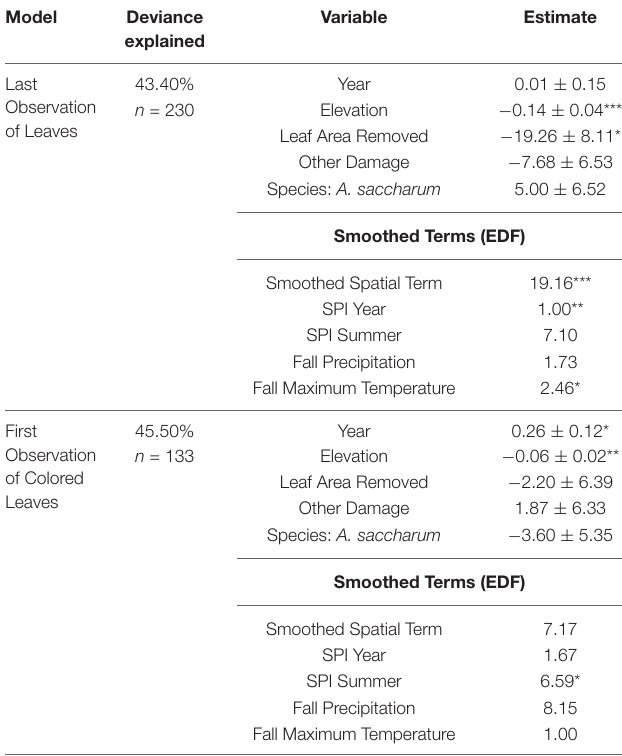
TABLE 1 | Results of linear regression of the last specimen date with leaves for each year and the first observation date of colored leaves after the summer solstice, weighted by the number of